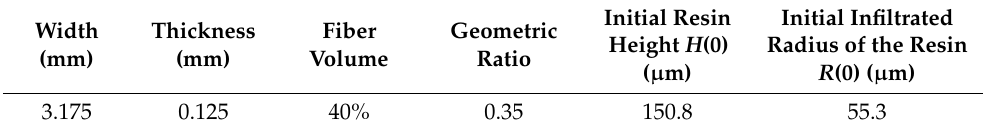
Figure 7. The RFP system and cross-sectional photomicrograph of prepreg tow.